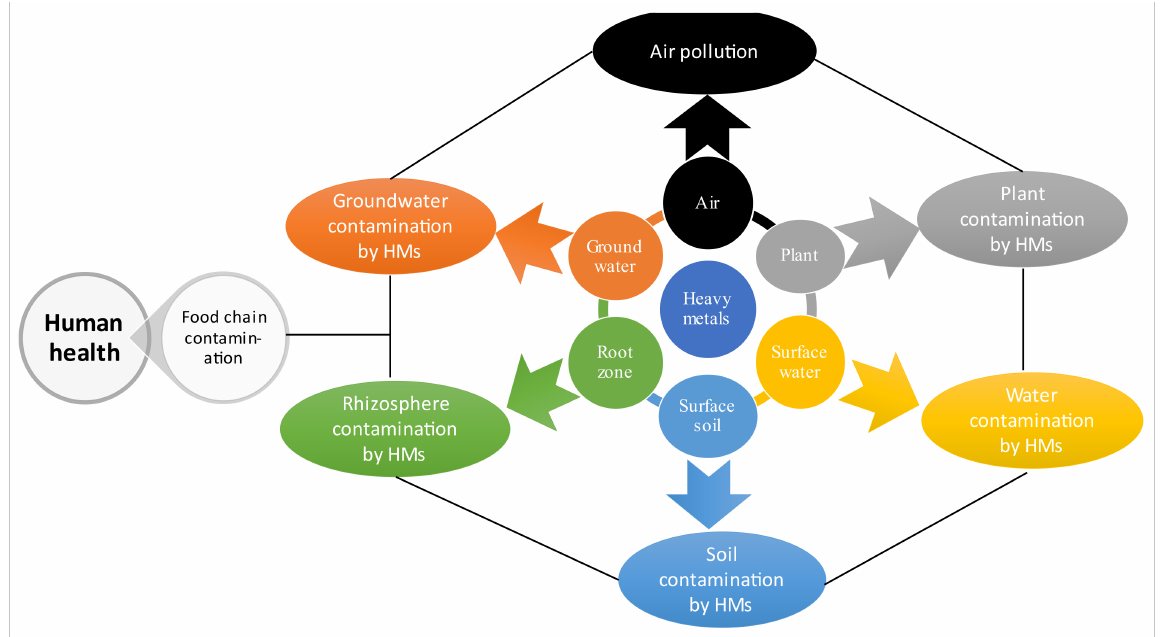
Figure 3. The possible environmental components affected by heavy metals that can introduce cadmium/lead to the food chain, affecting human health.